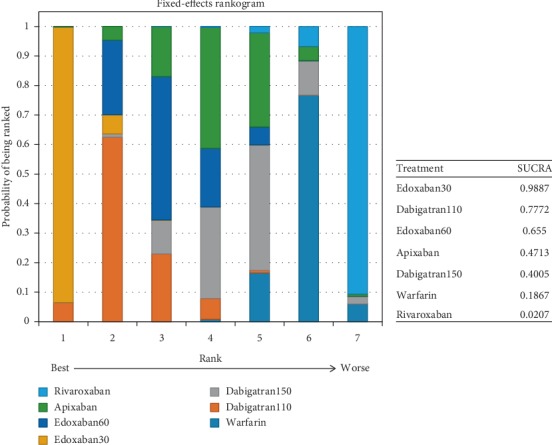
Ranking plots for the safety of the comparison among different treatments of patients with normal renal function.